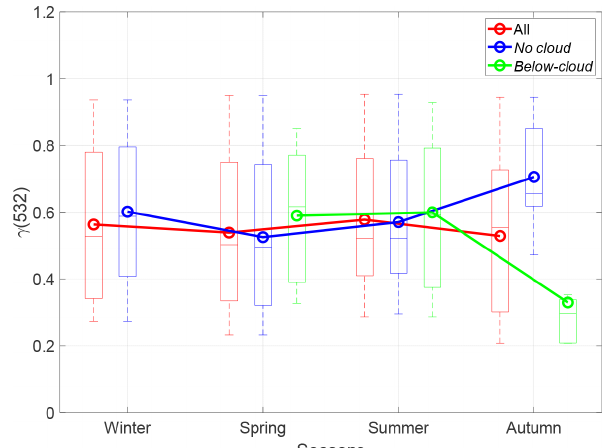
Figure 9. Box and whisker plot showing the 5, 25, 50, 75, and 95th percentiles of the seasonal values of γ (532) for all cases (red), and the No cloud (blue) and Below-cloud cases (green). Circles indi- cate the arithmetic mean. Seasonal percentiles and means are shown only when more than one data point is